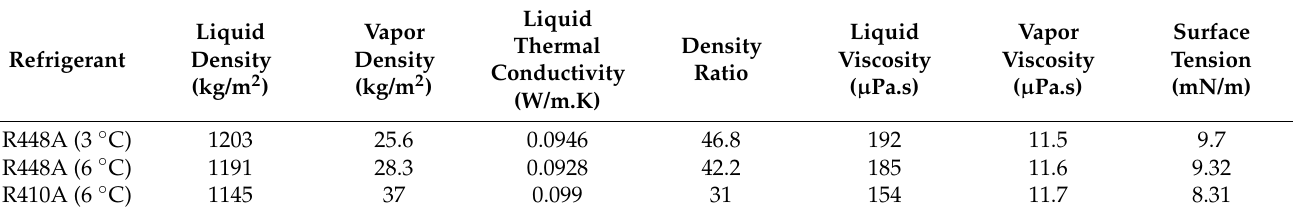
Table 3. Thermo-physical properties of R448A and